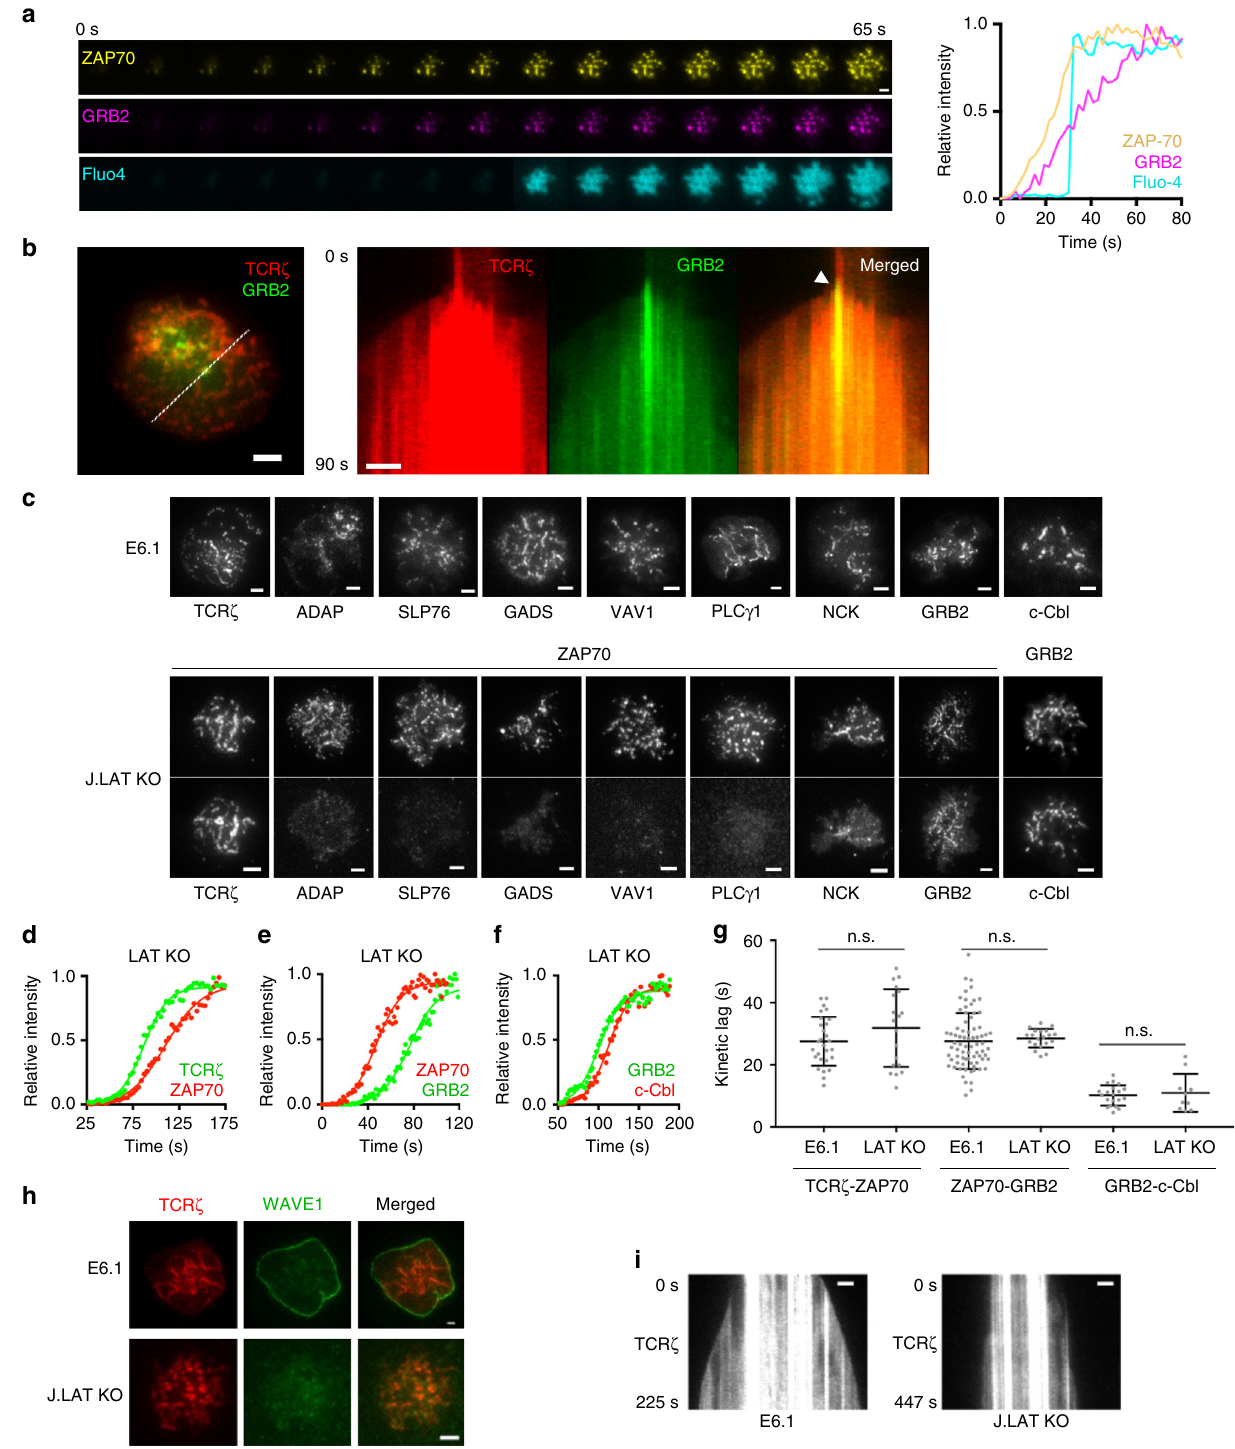
expansion in activated T cells. Whereas mEmerald-WAVE1 localized strongly to the leading edge of stimulated E6.1 cells, WAVE1 was not detected at the cell periphery in J.LAT KO cells (Fig. 5h), consistent with the key requirement of the LAT complex in F-actin polymerization-driven cell spreading. Addi- tionally, rapid cell spreading was not observed in stimulated J. LAT KO cells (Fig. 5i), despite the normal recruitment kinetics of TCR ζ , ZAP70, GRB2, and c-Cbl to microclusters (Fig. 5g). Together these results show that LAT is required for the